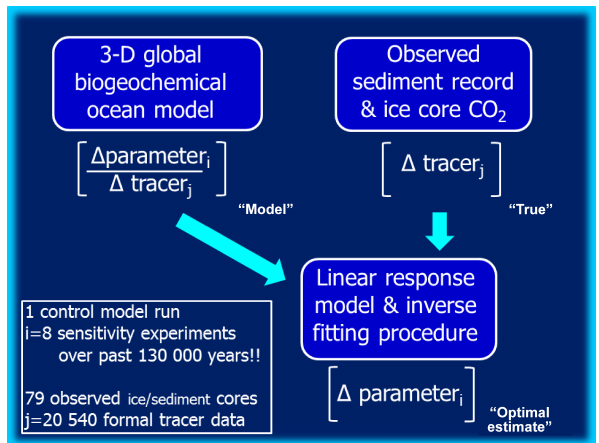
Figure 4. Fitting procedure combining the observed palaeoclimate data and the model-derived information on how the downcore dis- tributions of the various cores look for the different sensitivity ex-